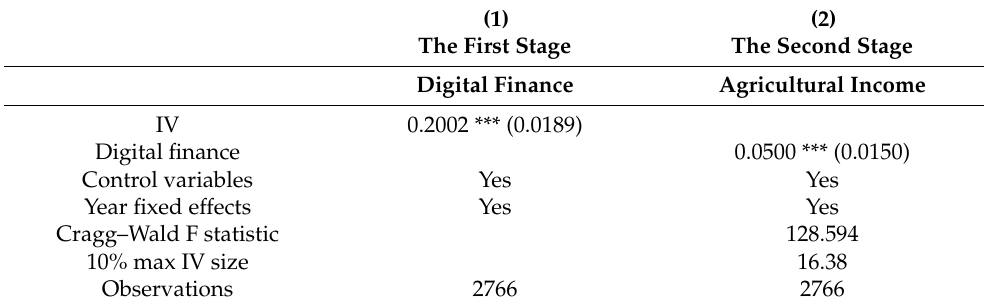
Table 3. Estimated results of